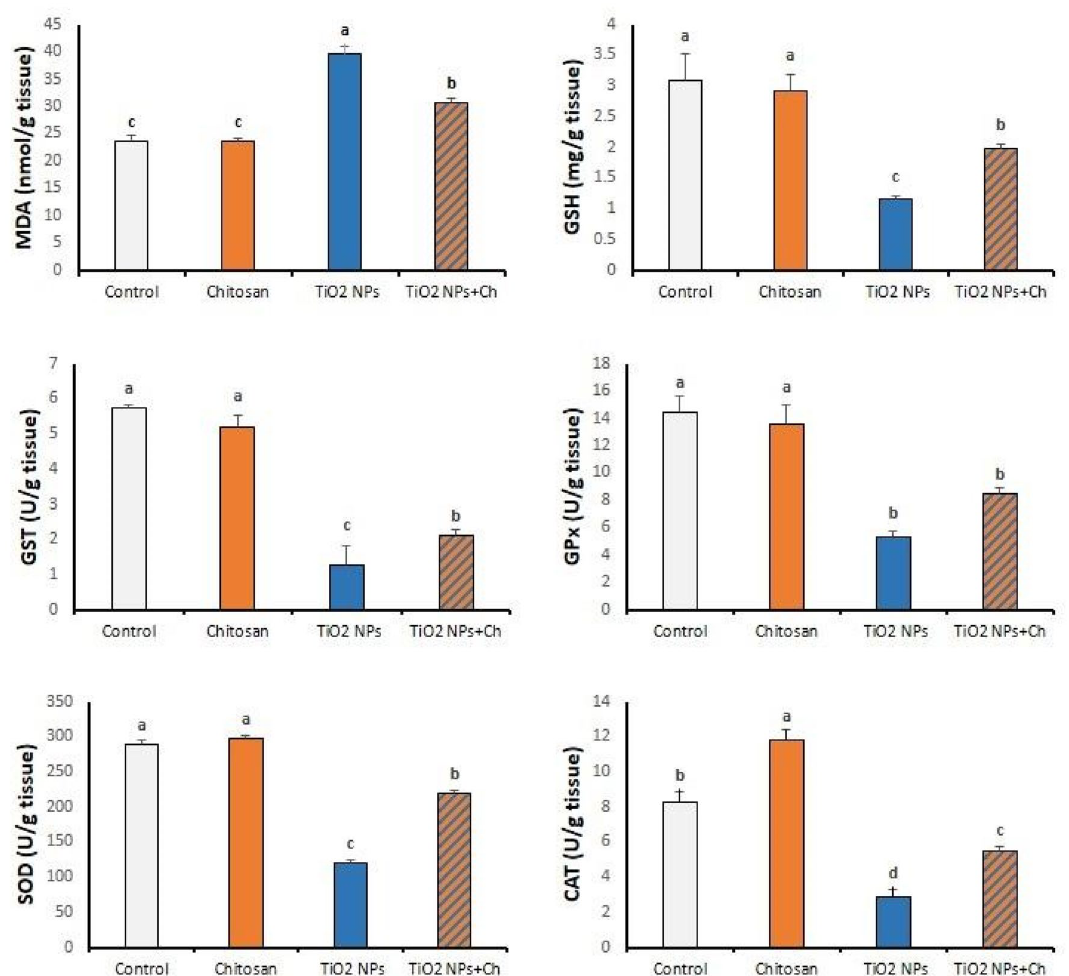
Figure 5. Effects of TiO 2 NPs and/or chitosan on testicular oxidative/antioxidant markers. data are presented as means ± SEM. data are presented as means ± SEM. Data are expressed as mean ± standard error of the mean (n = 5). Means in the same row with different superscripts are significantly different ( p < 0.05). MDA (malondialdehyde); GSH (Reduced glutathione); GST (Glutathione S transferase); GPx (Glutathione Peroxidase) SOD (superoxide dismutase) and CAT